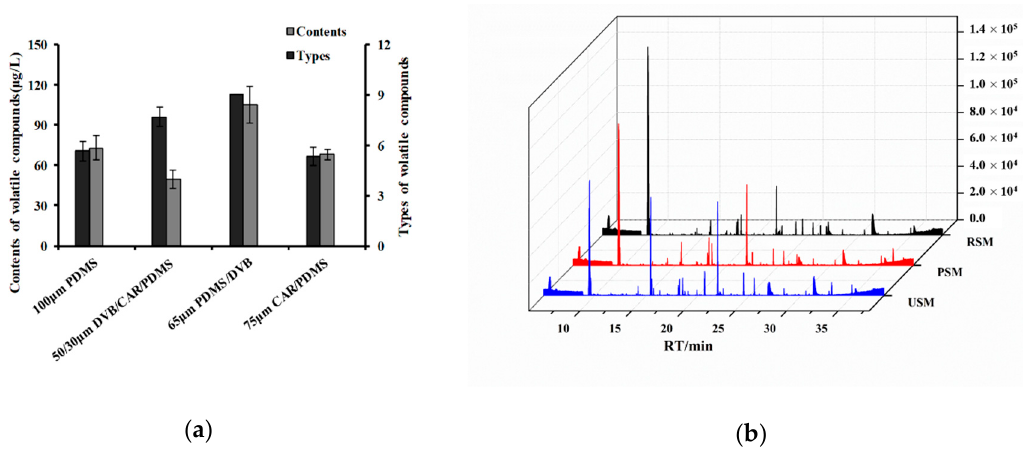
Figure 3. GC-MS analysis of volatile compounds from the milk samples: ( a ) Comparison of amounts and types of volatile compounds from milk extracted by four types of solid-phase microextraction (SPME) fiber (100 µ m polydimethylsiloxane (PDMS), 50 / 30 µ m DVB / CAR / PDMS, 65 µ m PDMS / divinylbenzene (PDMS / DVB), and 75 µ m carboxen / PDMS (CAR / PDMS); all from Supelco Inc., Bellefonte, PA, USA). Means within a group followed by di ff erent letters (a–c) are di ff erent ( p < 0.05). ( b ) Total ion currency (TIC) profile of the volatiles from three kinds of skim milk samples.